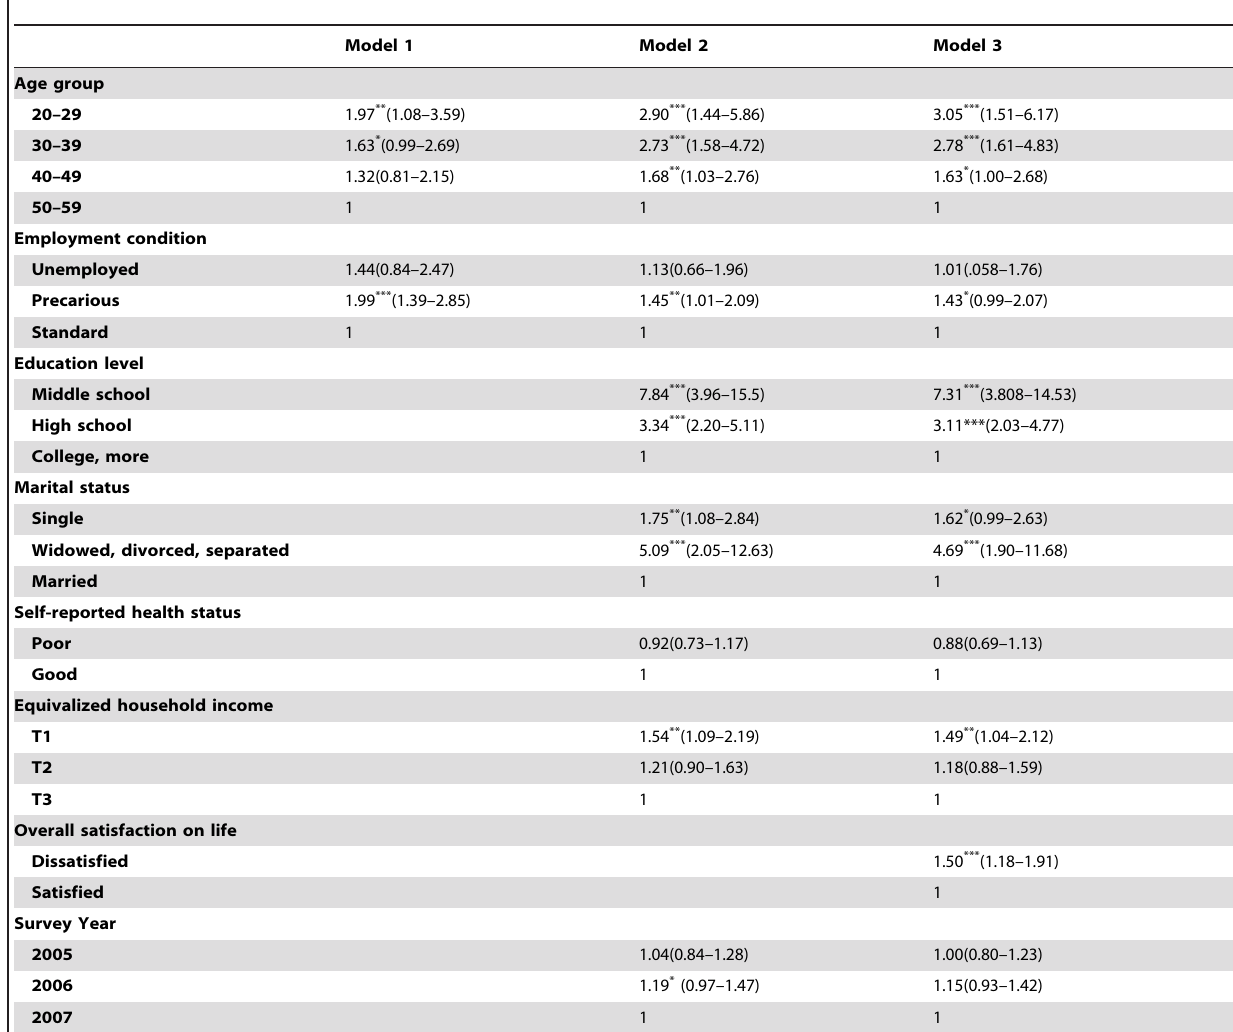
Table 2. Adjusted odds ratios a (95% confidence interval) of current cigarette smoking according to employment